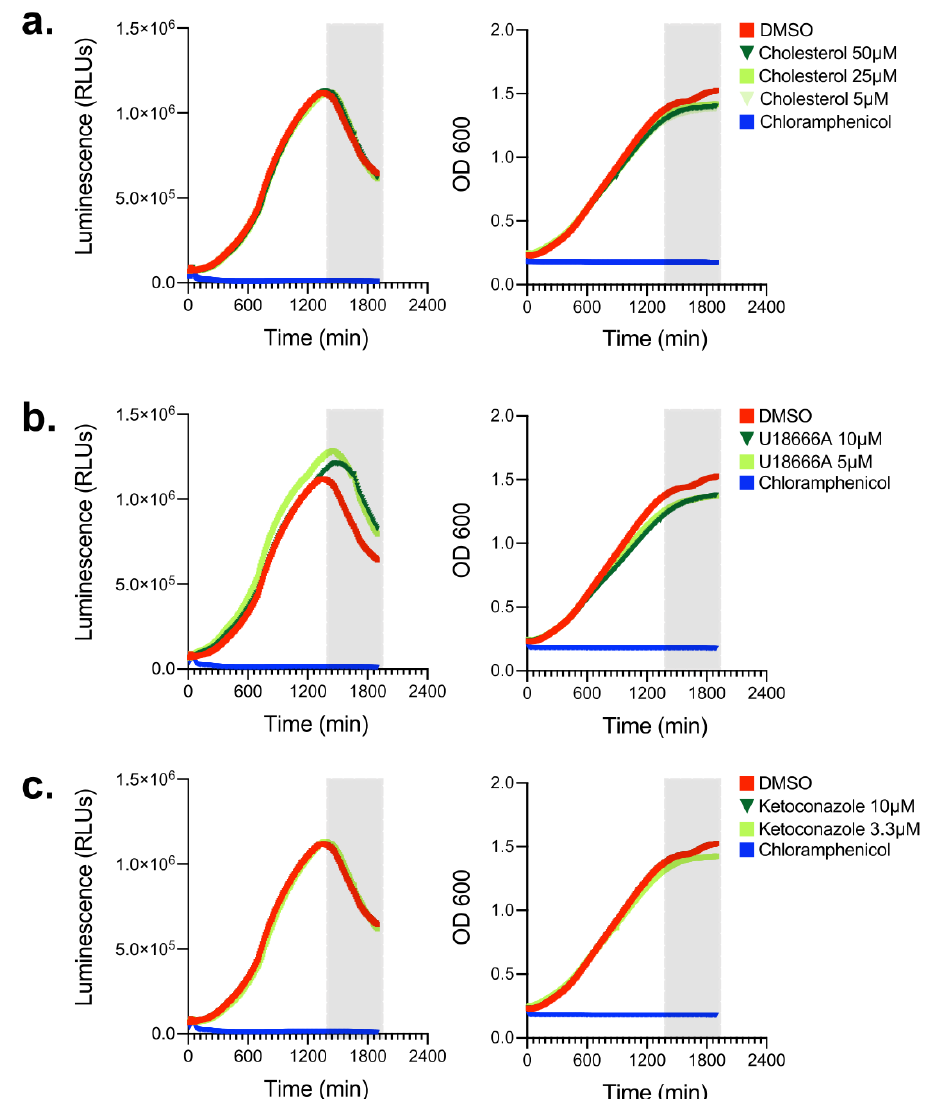
FIGURE 2: Effects of choles- terol, U18666A and ketocona- zole on bacterial growth and luminescence production in axenic cultures. (a-c) Lumines- cence output of the Lp icmRp - LuxR measured every ten min in axenically grown AYE liquid cultures in the pres- ence/absence of different concentration of cholesterol (a) , U18666A (b) , or ketocona- zole (c) over the indicated time period. Each timepoint repre- sents an average of technical triplicates. Grey panel denotes entry into stationary phase. (a- c) Representative data from one of three biological repli- cates are